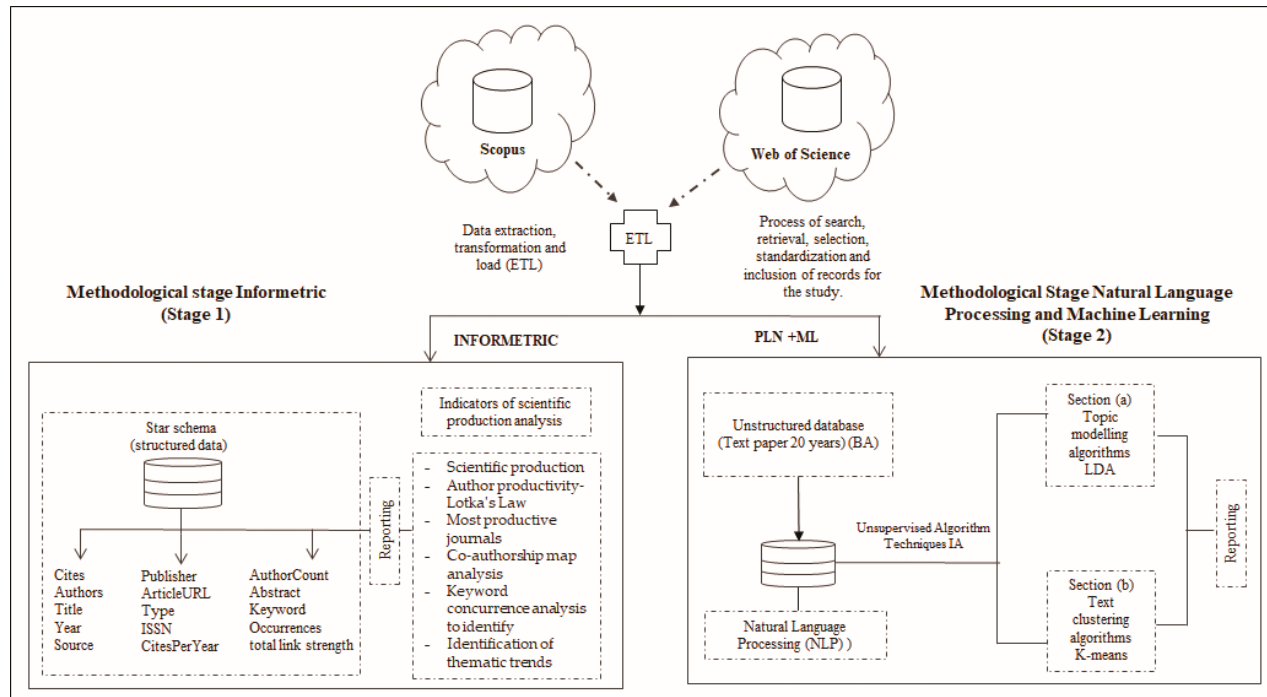
Figure 1. Methodological design for information analysis prepared by the authors. Research Data Sample: